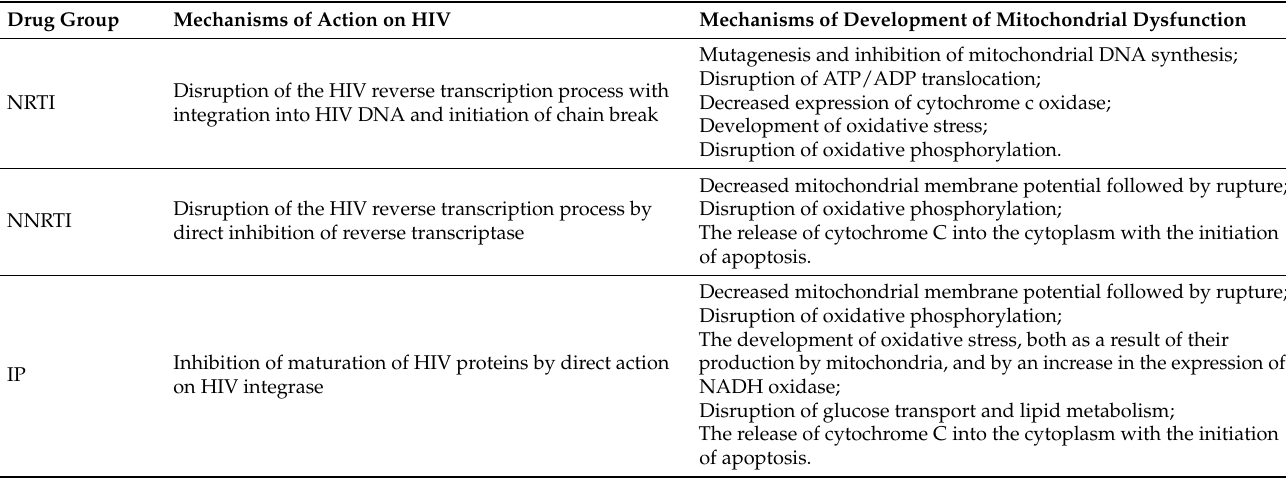
Table 1. Impact of ART drugs on the development of mitochondrial dysfunction in